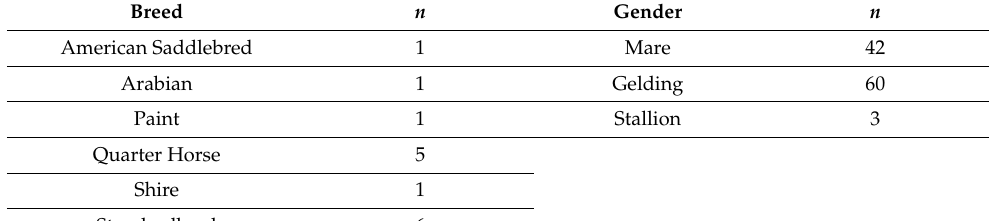
Table 1. Distribution of 105 equine cases affected with suture exostosis in terms of breed, gender and age. Breed